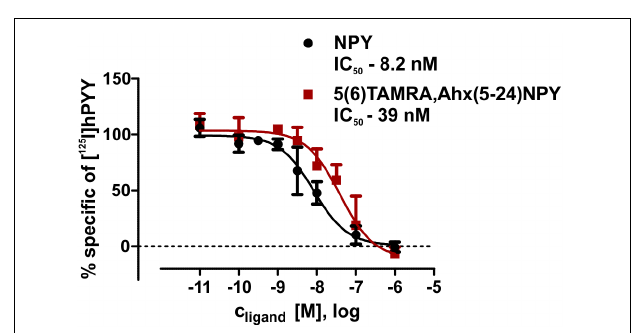
FIGURE 4 | Summary of binding assays with membrane preparations of transiently transfected HEK293 cells. IC 50 values were determined by